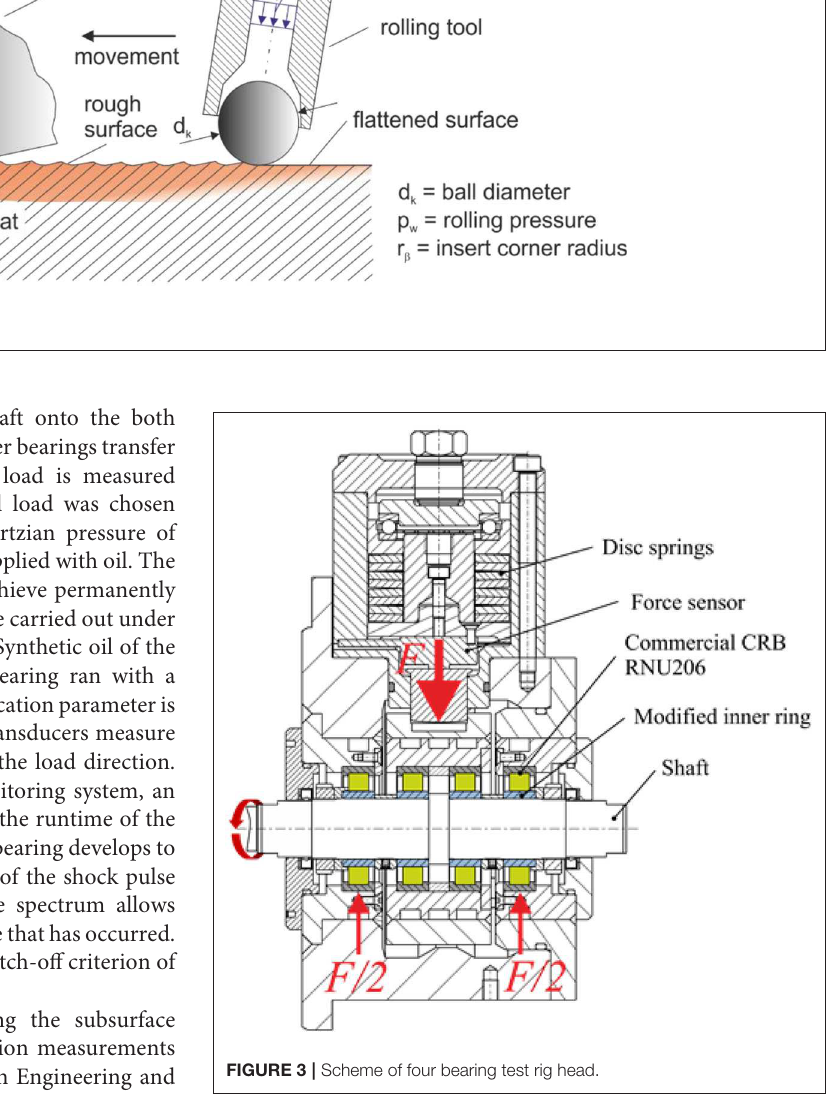
FIGURE 3 | Scheme of four bearing test rig